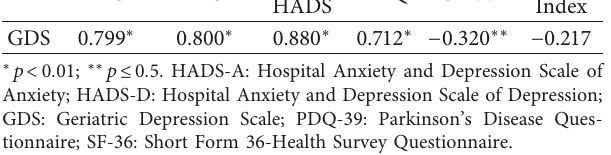
Table 2: Pearson’s correlation coefficient for each comparison. HADS-A